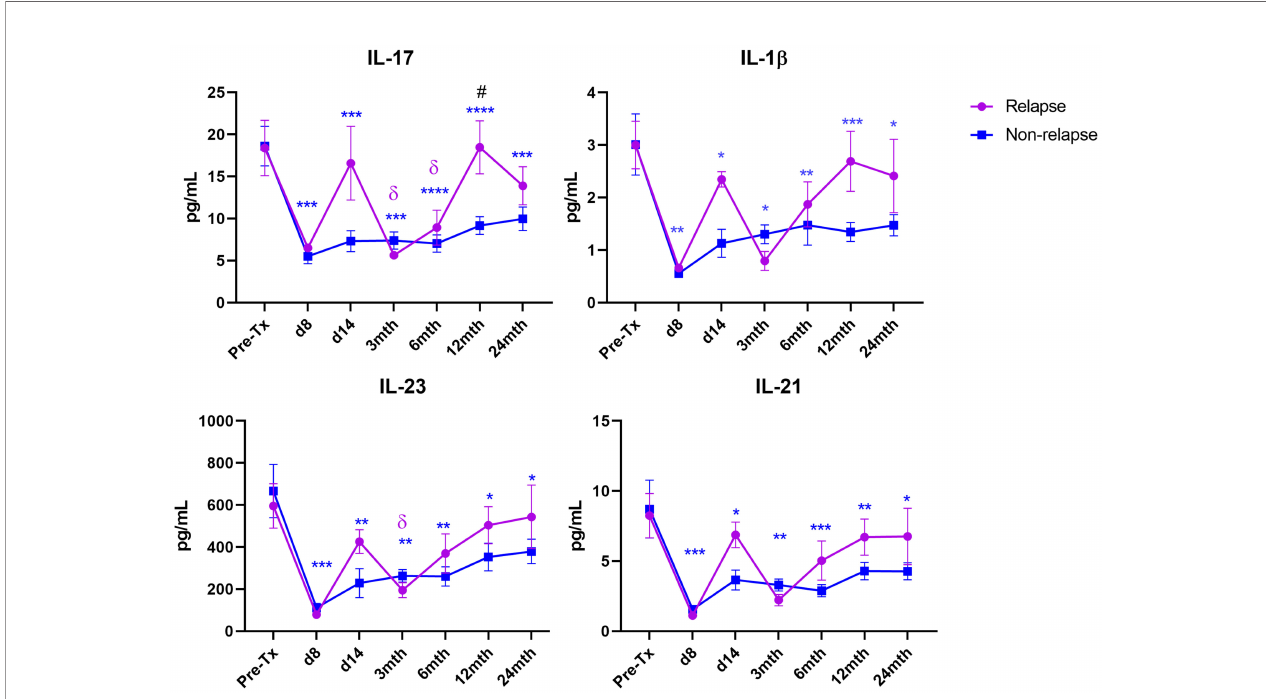
FIGURE 3 | Th17 cytokine levels in relapse and non-relapse MS patients following AHSCT. Cytokine concentrations were quanti fi ed at pre-AHSCT (pre-Tx), day 8 and day 14, and at 3 months (mth), 6 months, 12 months, and 24 months post-AHSCT in relapsed (n=4) and non-relapsed patient cohorts (n=18). Sample sizes per timepoint within each cohort are as follows: 1) Pre-Tx: Relapsed n=4; Non-Relapsed n=18, 2) Day 8: Relapsed n=1; Non-Relapsed n=8, 3) Day 14: Relapsed n=2; Non-Relapsed n=8, 4) 3 months: Relapsed n=4; Non-Relapsed n=17, 5) 6 months: Relapsed n=4; Non-Relapsed n=17, 6) 12 months: Relapsed n=4; Non-Relapsed n=17, 7) 24 months: Relapsed n=4; Non-Relapsed n=17. Comparison of mean cytokine concentrations between relapsed and non-relapse cohorts at each timepoint was performed using a two-way repeated measures ANOVA with Sidak post-hoc . Comparison of each post-AHSCT timepoint to Pre-Tx was performed using a one-way repeated measures ANOVA with Holm-Sidak post-hoc . Symbols represent signi fi cant difference between pre-AHSCT and a post-AHSCT timepoint in each cohort. Non-Relapsed cohort: * p < 0.05; ** p < 0.01; *** p < 0.001; **** p < 0.0001. Relapsed cohort: d p < 0.05. # ( p < 0.05) represents a signi fi cant difference between the relapse and the non-relapse cohort at each